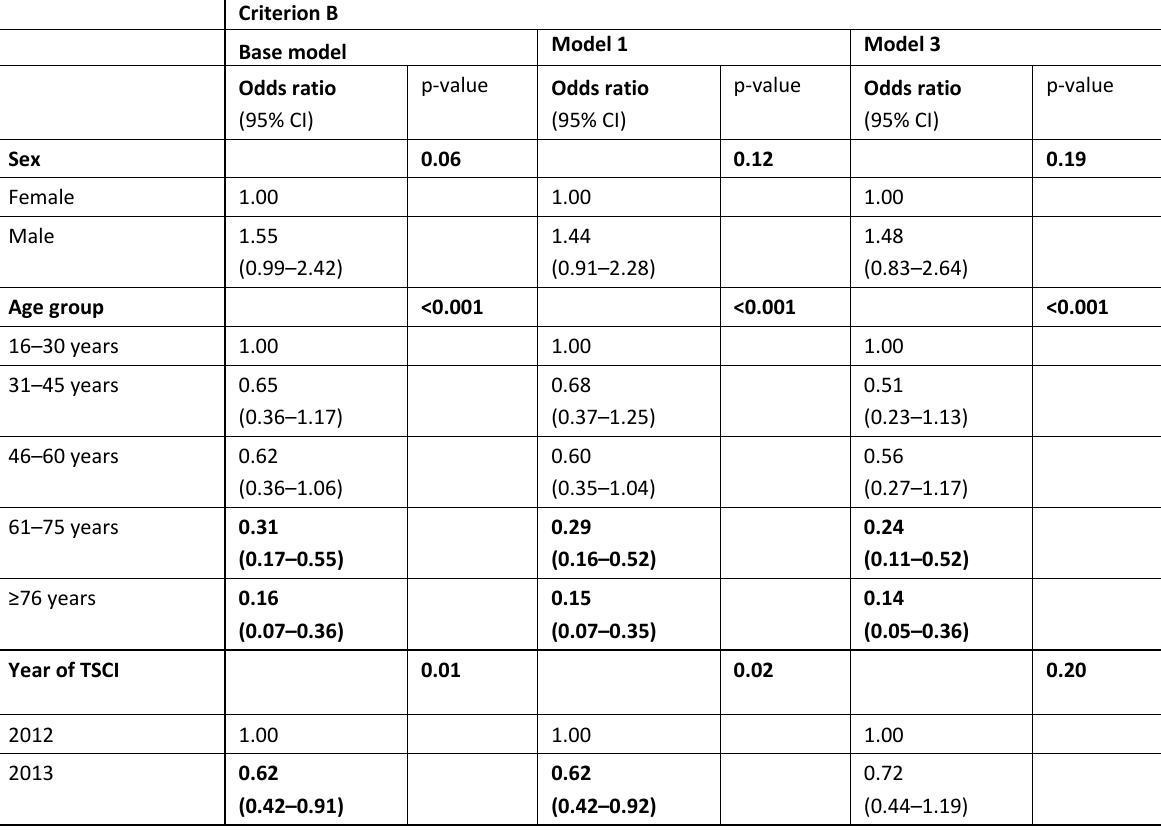
Table S1: Analysis excluding 40 cases from 2012 with the highest propensity to be erroneously coded for having a new